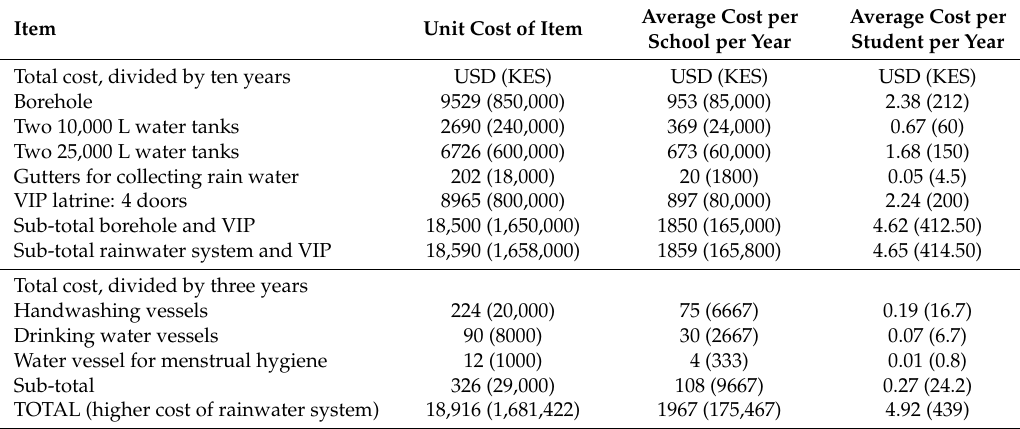
Table 4. Setting up a school WASH program: Capital Hardware costs, Kenya 2014.